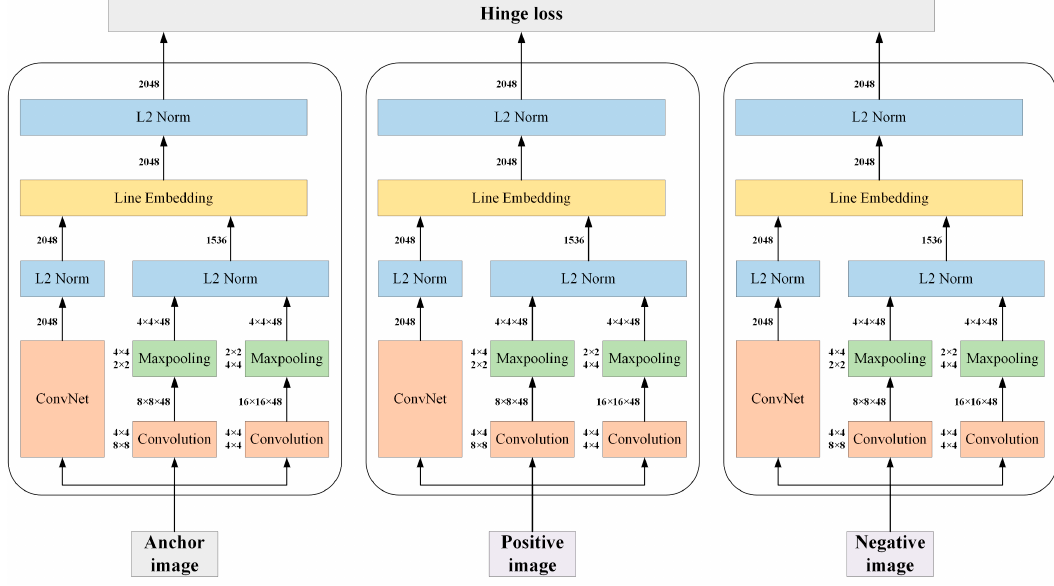
Figure 4. The architecture of the deep ranking model.